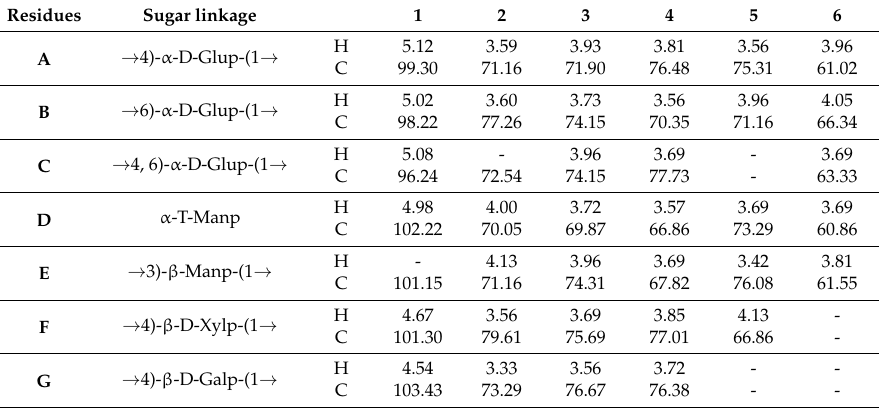
Table 1. The 1 H and 13 C NMR shifts of NMCP-2 in D 2 O at 298 K.